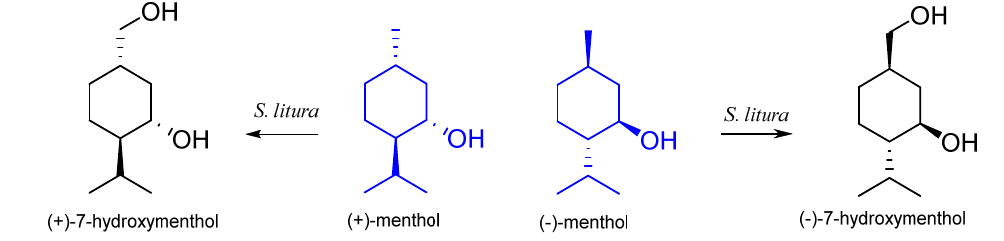
Scheme 13. Biotransformation of menthol by